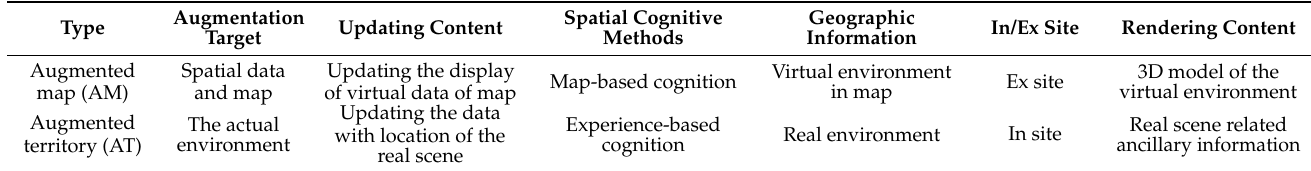
Table 1. Comparison between augmented map and augmented